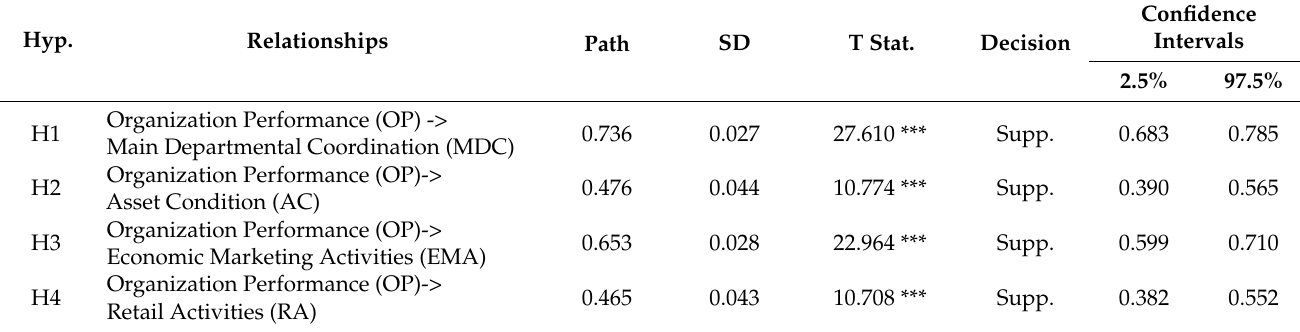
Table 4. Hypothesis results.